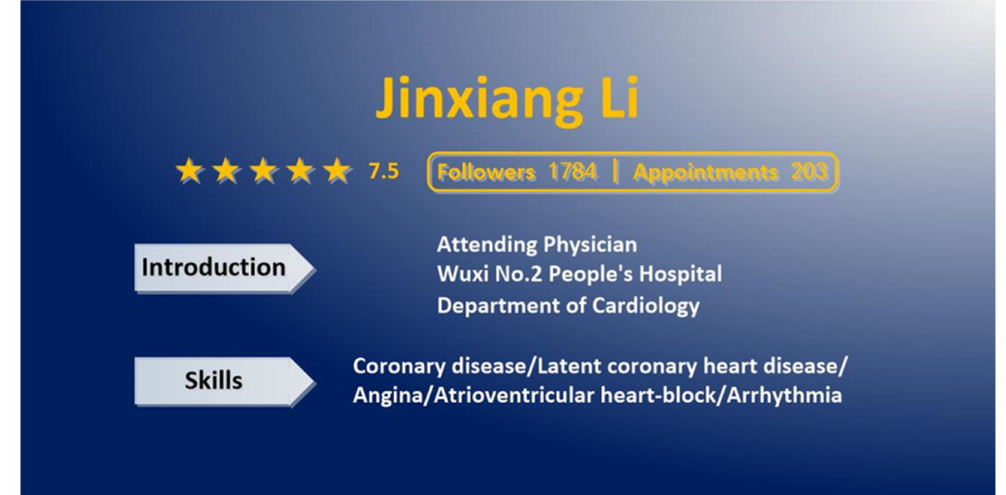
Figure 2. The description of the physician who did not join any